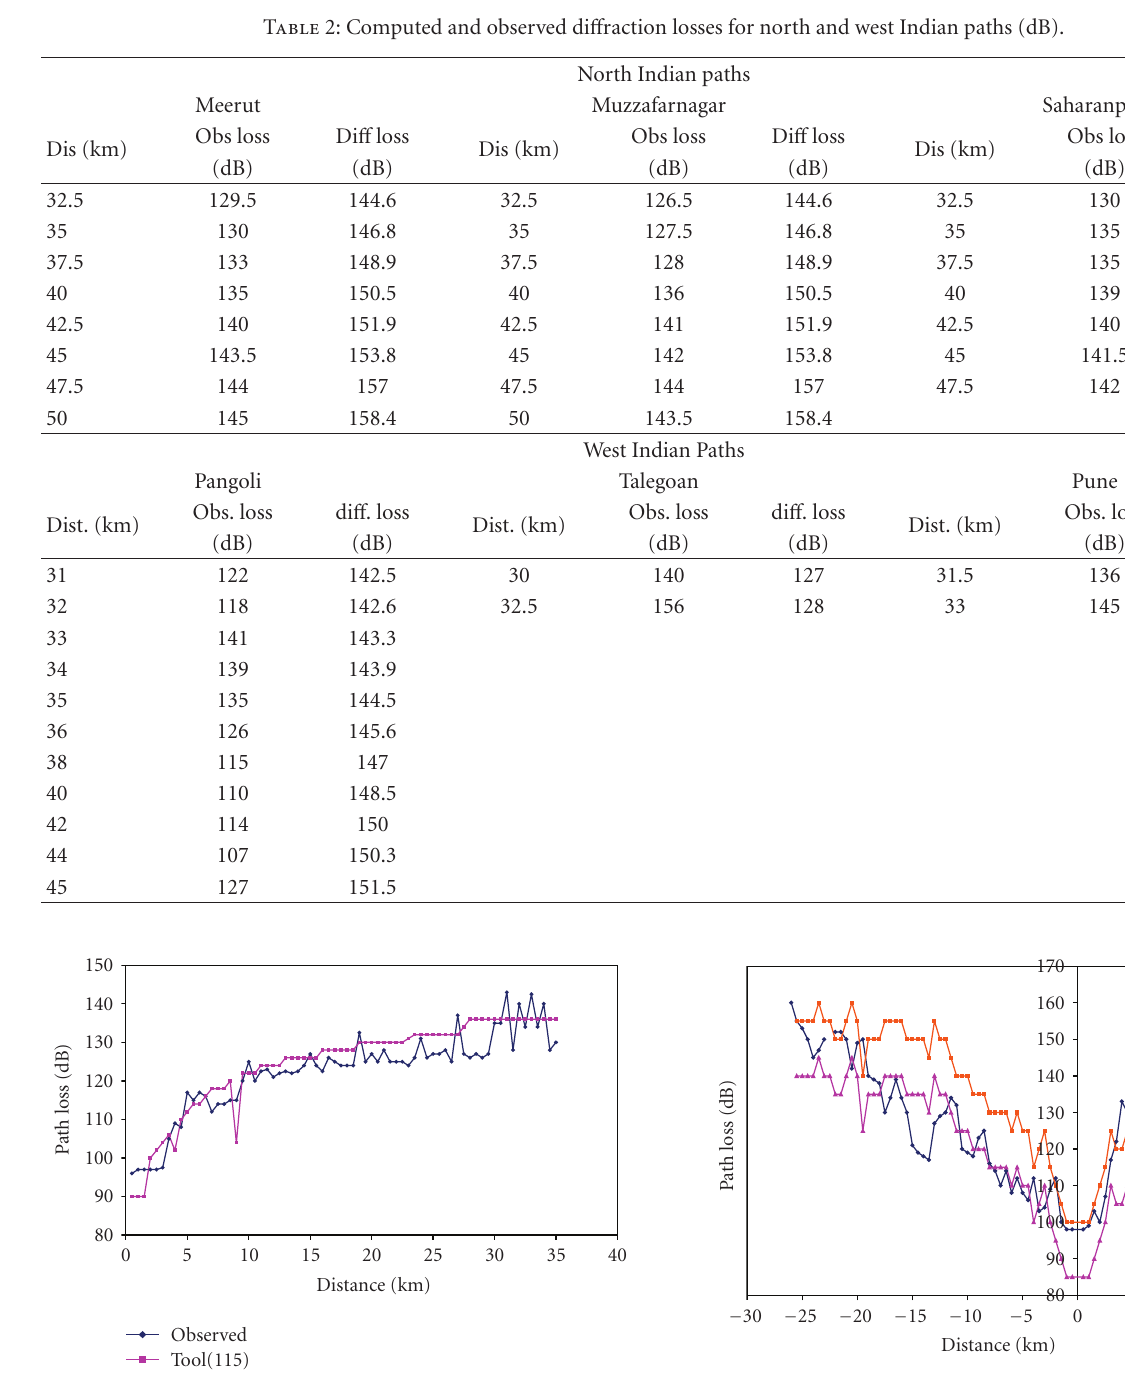
Figure 7: Comparison of tool predicted losses with observed losses versus track distance for Saharanpur base station. factor for Hms. K5 is e ff ective antenna height gain. This is the multiplying factor for the log of the e ff ective antenna height K6. This is the Okumura-Hata type multiplying factor for log(He ff ) log( d ). K7 takes into account di ff raction e ff ects. A choice of di ff raction methods is available.